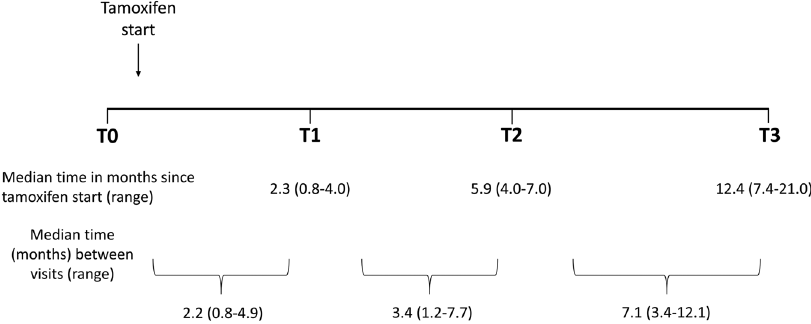
Fig. 3 Study design for ultrasound tomography scans and endocrine symptom assessment in the Ultrasound Study of Tamoxifen. Ultrasound tomography scans and endocrine symptoms were ascertained prior to tamoxifen initiation (T0) and post-tamoxifen initiation (T1 –